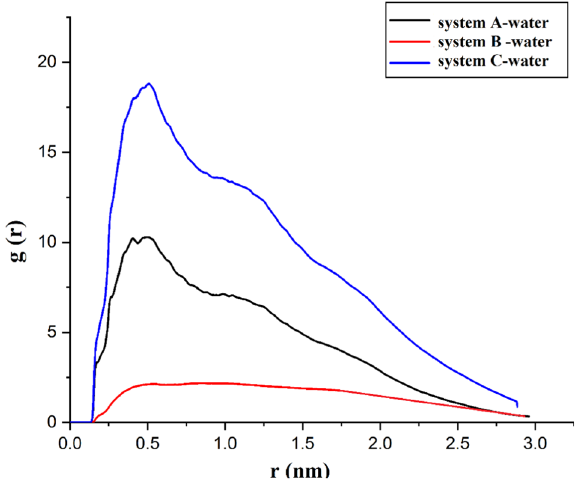
Fig. 9 RDF pattern. The RDF of the water molecules around the OH